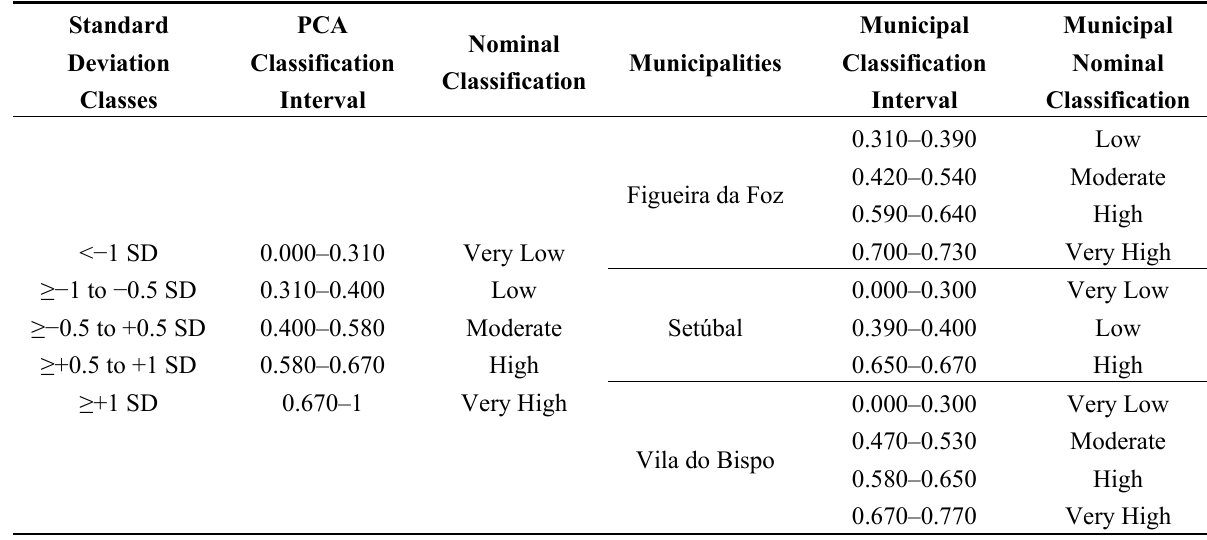
Figure 12. Social vulnerability: ( a ) Figueira da Foz municipality; ( b ) Setúbal municipality; and ( c ) Vila do Bispo municipality. Table 3. Social vulnerability